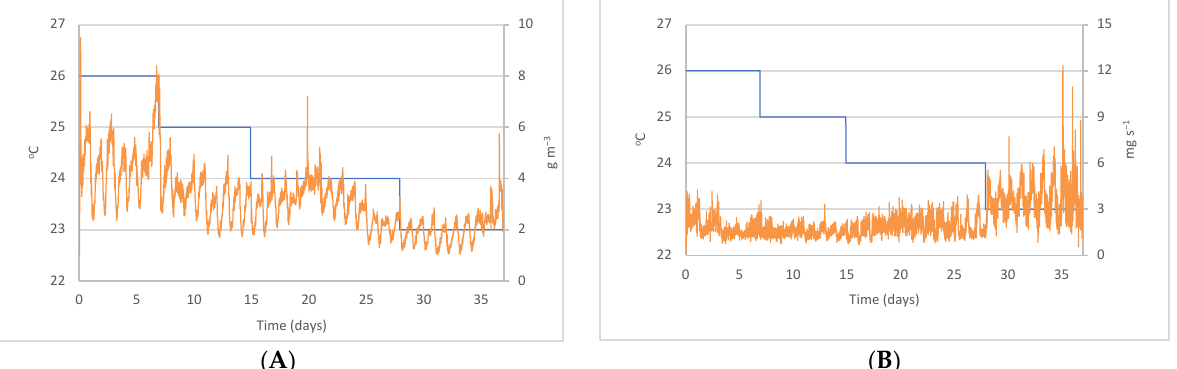
Figure 2. Evolution during the cycle of ( A ) CO 2 concentration, – C CO2 (g m − 3 ), and ( B ) CO 2 emissions per animal, – E CO2 (mg s − 1 ), with setpoint temperature, – T S (°C).